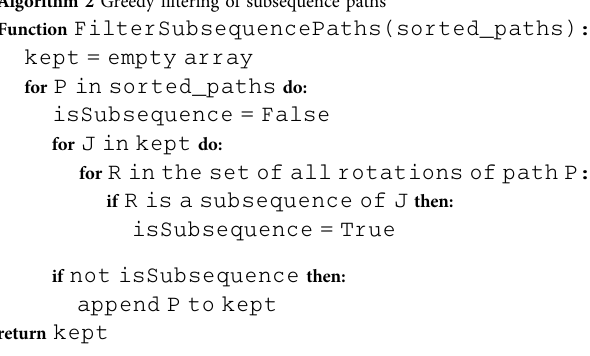
Algorithm 2 Greedy fi ltering of subsequence